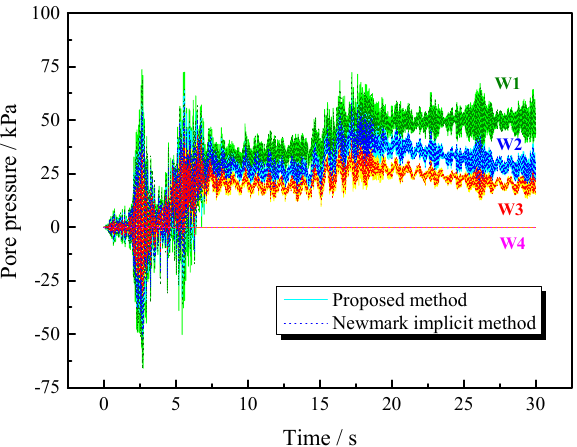
maximum horizontal and vertical displacements reaching 0.13 m and 0.19 m, respectively, at 30 s.